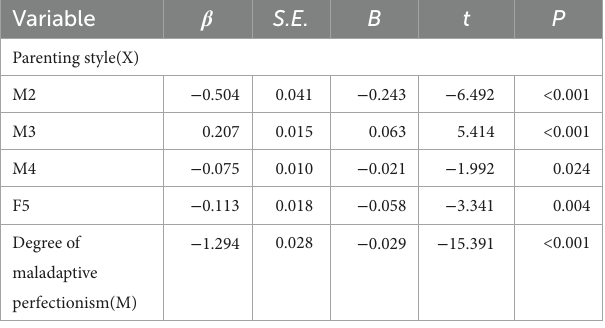
TABLE 6 Multiple linear regression analysis of the effects of maladaptive perfectionism and parenting style on moral judgment ability in patients with OCD.